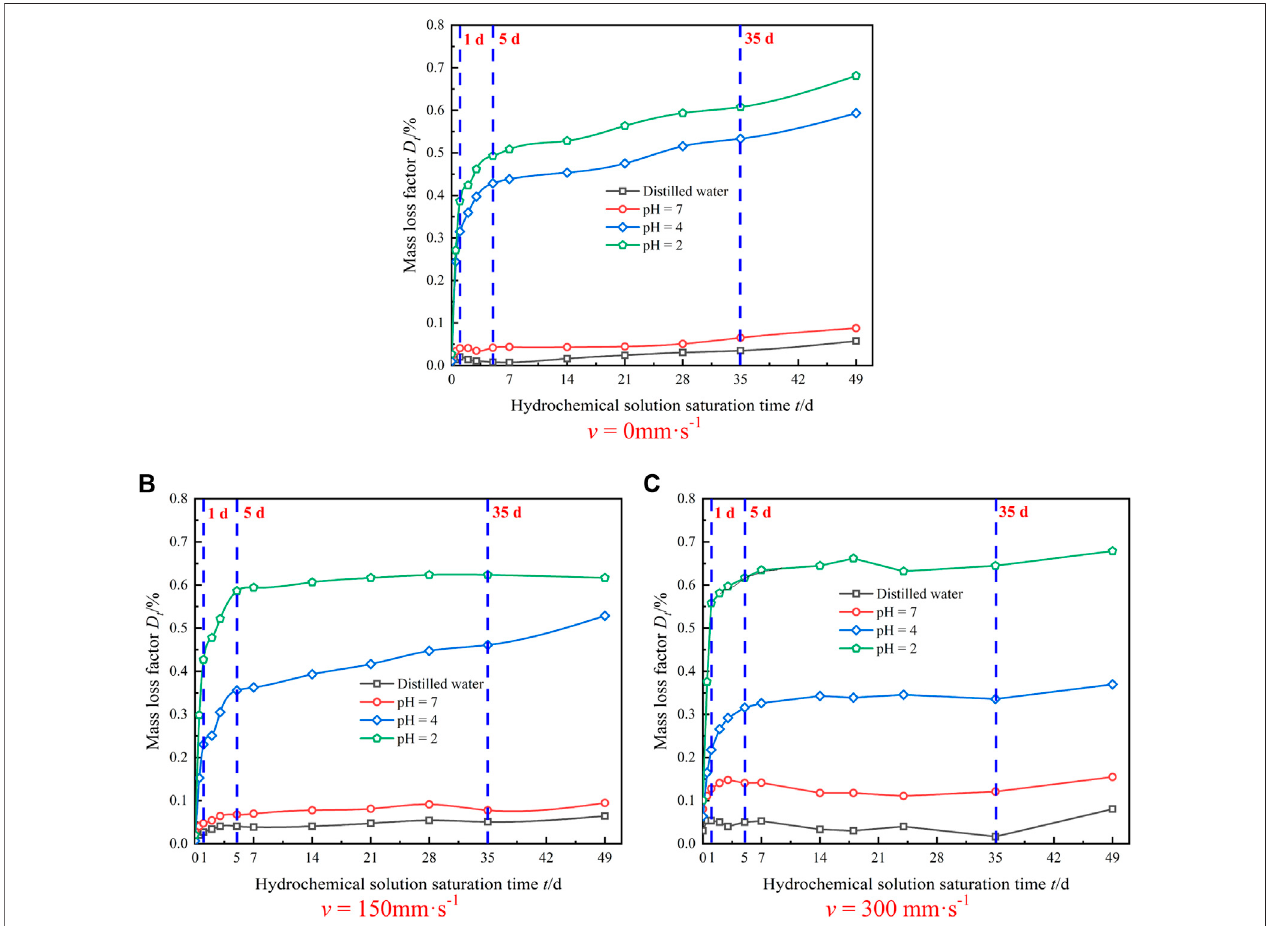
FIGURE 7 | Time-dependent variation curve of rock mass loss during the test process. (A) v = 0 mm · s -1 . (B) v = 150 mm · s -1 . (C) v = 300 mm · s -1 .